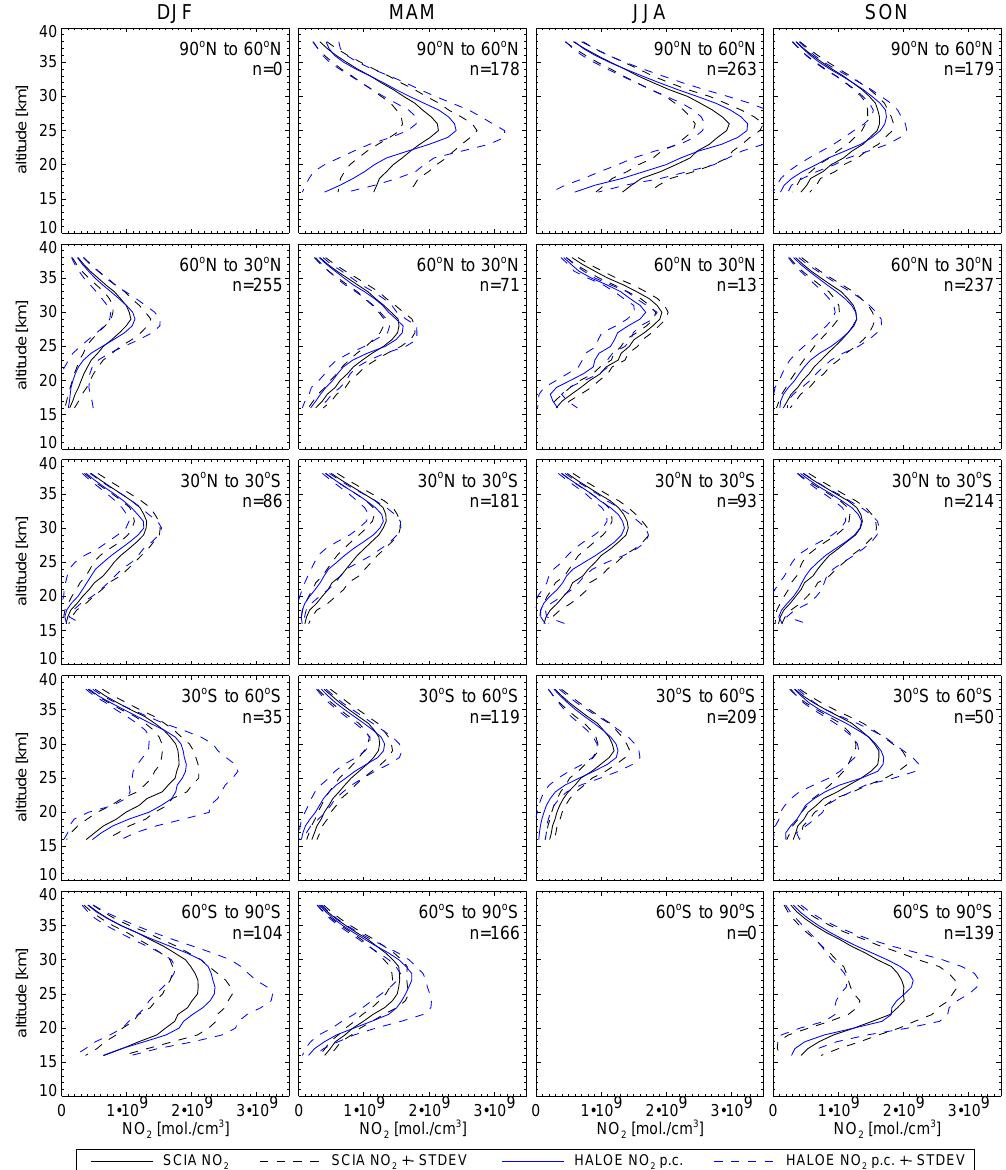
Fig. 12. Same as Fig. 9, but for HALOE data.